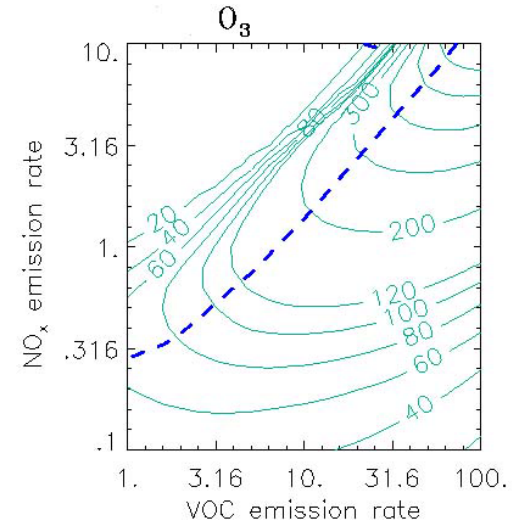
Figure 9. Ozone isopleths (ppb) as a function of the average emis- sion rate for NO x and VOC (in 10 12 molec.cm − 2 s − 1 ) in 0-D cal- culations. The isopleths (solid green lines) represent conditions dur- ing the afternoon following 3d calculations with a constant emis- sion rate at the hour corresponding to maximum O 3 . The short blue dashed line represents the transition from VOC-sensitive to NO x - sensitive conditions. Adapted from Sillman and He